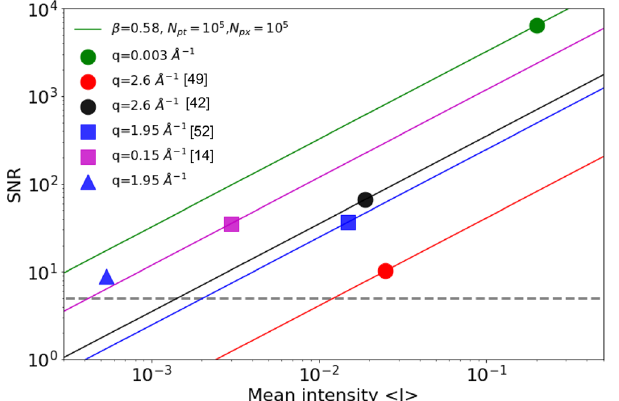
Figure 4. Signal-to-noise (SNR) ratio as a function of mean photon intensity measured for different experimental configurations at FEL during static speckle contrast (circles) and dynamic (squares) XPCS studies reported in 14,42,49,52 . Horizontal dashed line denotes the SNR of 5. Blue triangle shows calculated SNR for the ps - ns XPCS study with the split-and-delay on the water sample based on experimental conditions described in 52